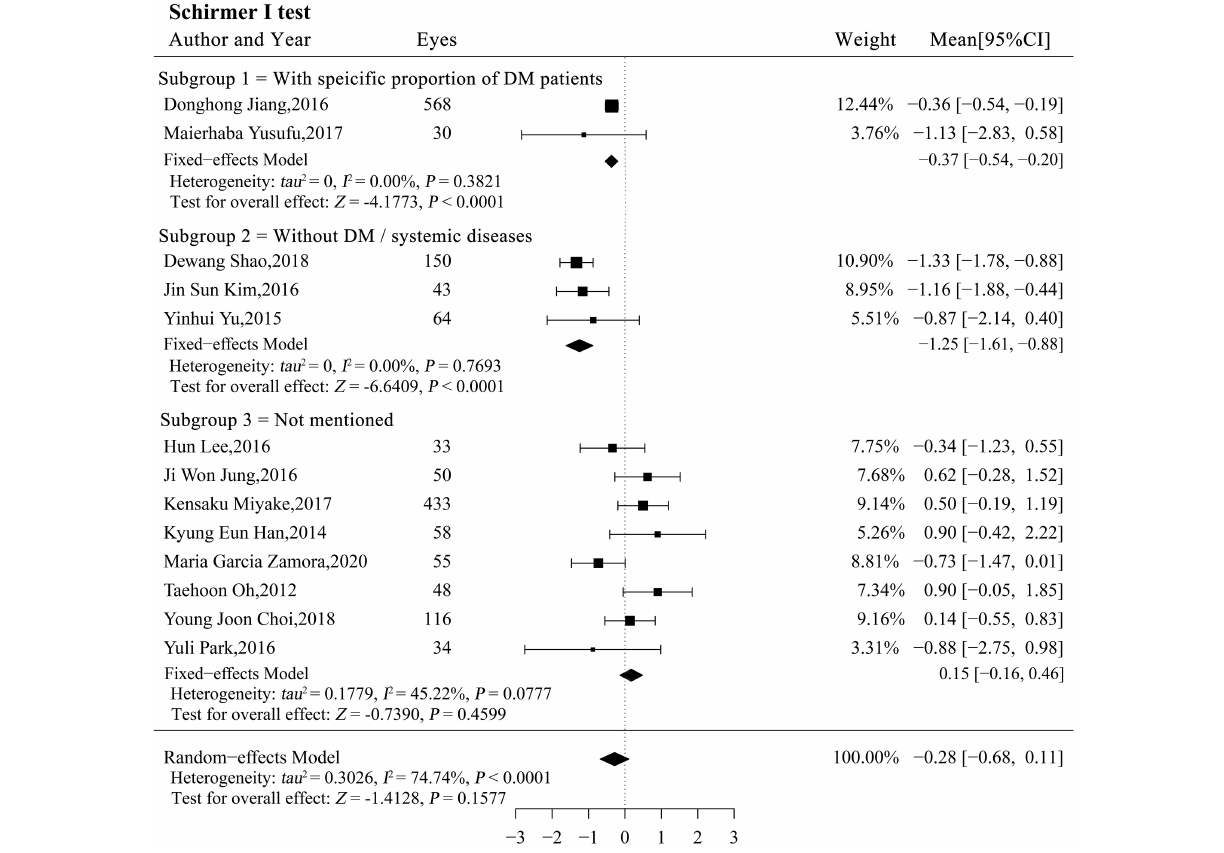
Index (range: 0–48) may be subclinical (48). However,